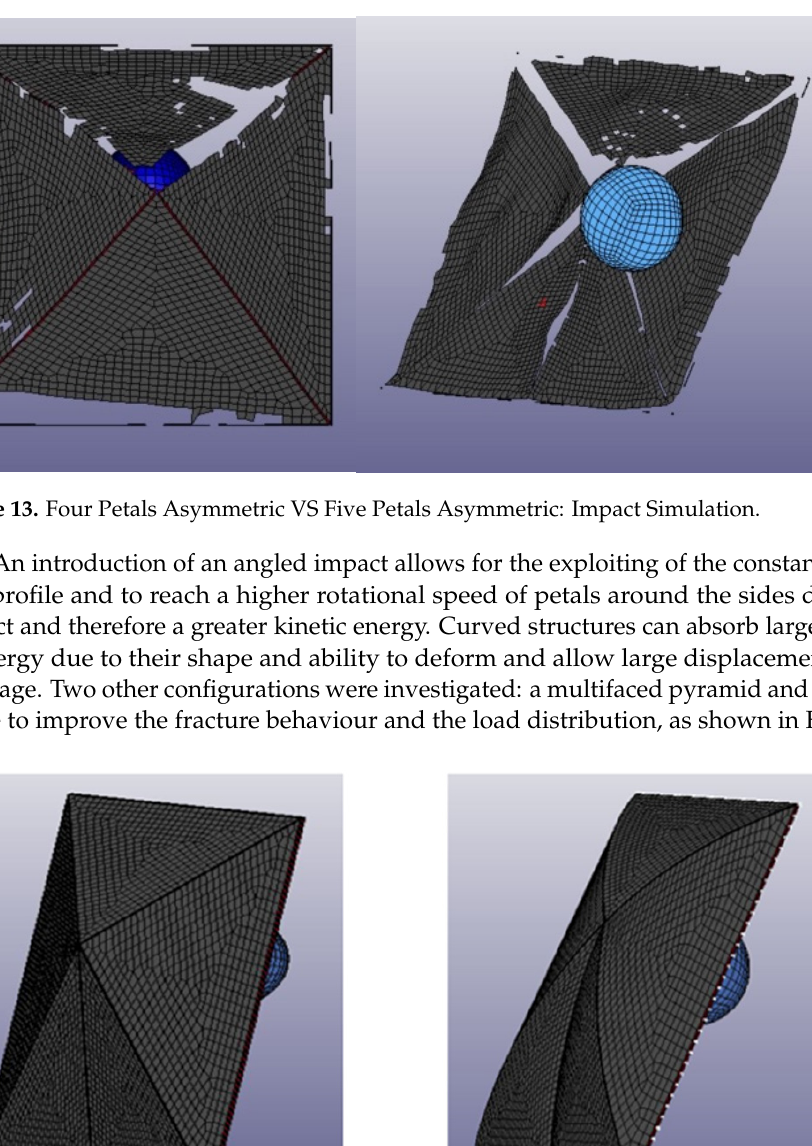
Figure 12. Planar Tailgates: stress distribution. The numerical simulations underlined how the asymmetric configuration with five at the same time, hindering launch, as shown in Figure 13.